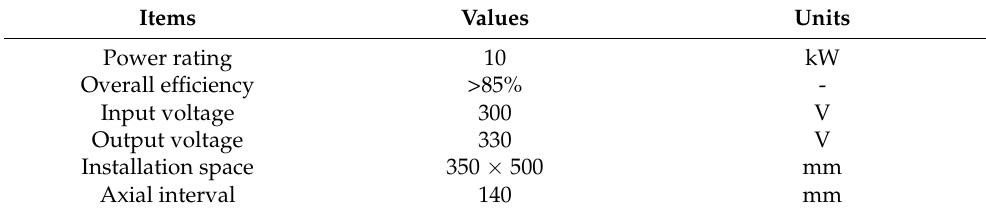
Table 1. Design guidelines and constraints.